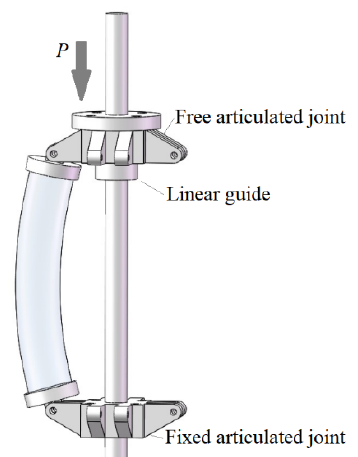
Figure 4. The simple model of vibration isolation unit.